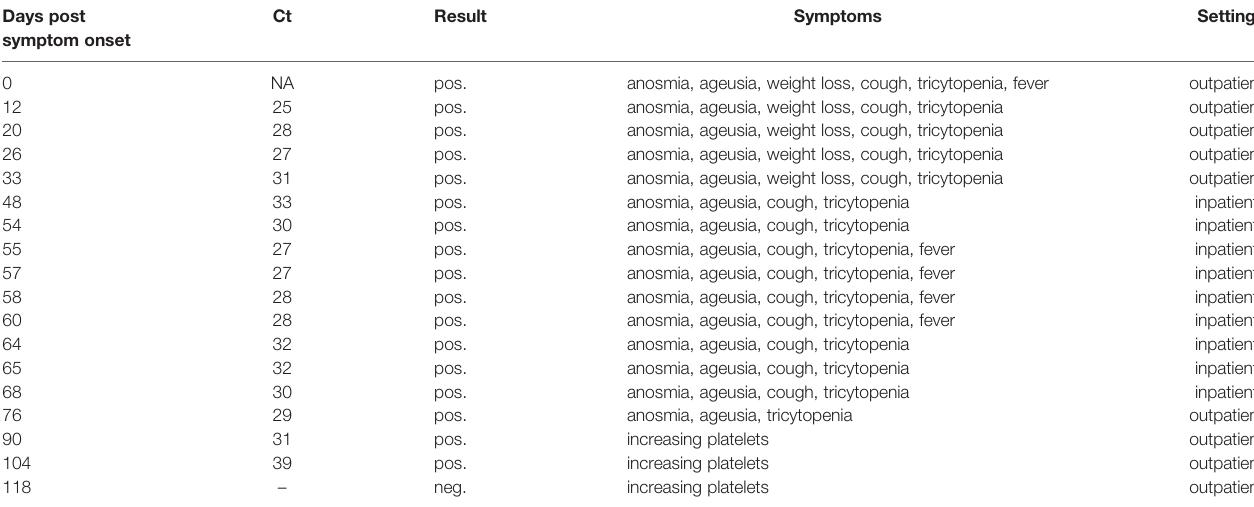
TABLE 1 | SARS-CoV2 Ct values, COVID-19 symptoms and hospitalization data. Days post symptom